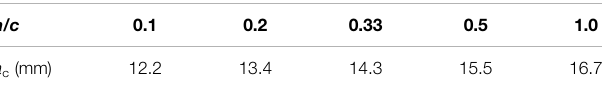
FIGURE 5 | Geometries for underclad semi-elliptical cracks. TABLE 2 | Acceptable embedded crack sizes with the allowable residual life of 2